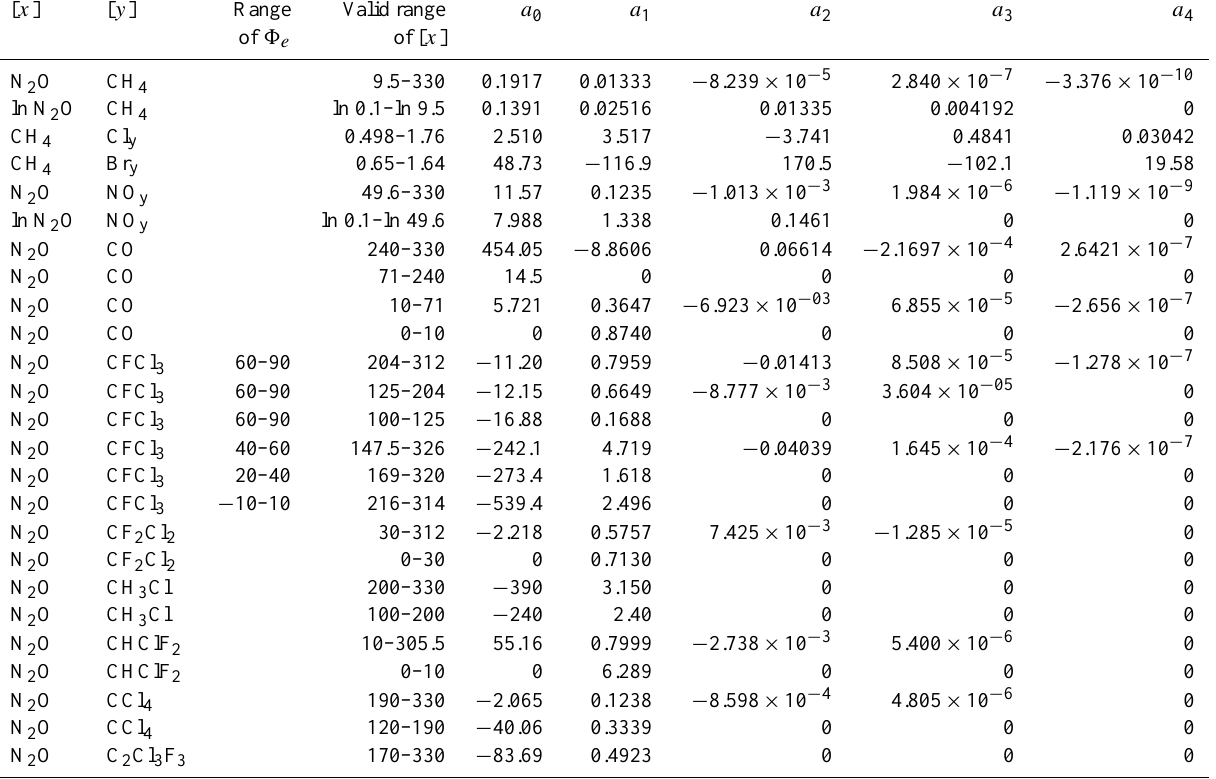
Table A2. Tracer correlations used in the initialisation procedure. The tracer correlations are derived from the observations using a polynomial a i ·[ x ] i and degree n ≤ 4. The unit of CH 4 is ppmv, the units of N 2 O, Cl y , NO y , and CO are ppbv and the unit fit of the form [ y ] = P n i = 0 of Br y and halocarbons is pptv. For values of [ x ] outside of the valid range, the closest valid value was used. The correlations are based on ACE-FTS version 3.0 data from October and November 2009 for equivalent latitudes greater then 50 ◦ N with the exception of Cl y and Br y that are taken from Grooß et al. (2005). The initialisation of CFCl 3 (CFC-11) is based on a wider range of equivalent latitudes ( 8 e ) given in the third column (in